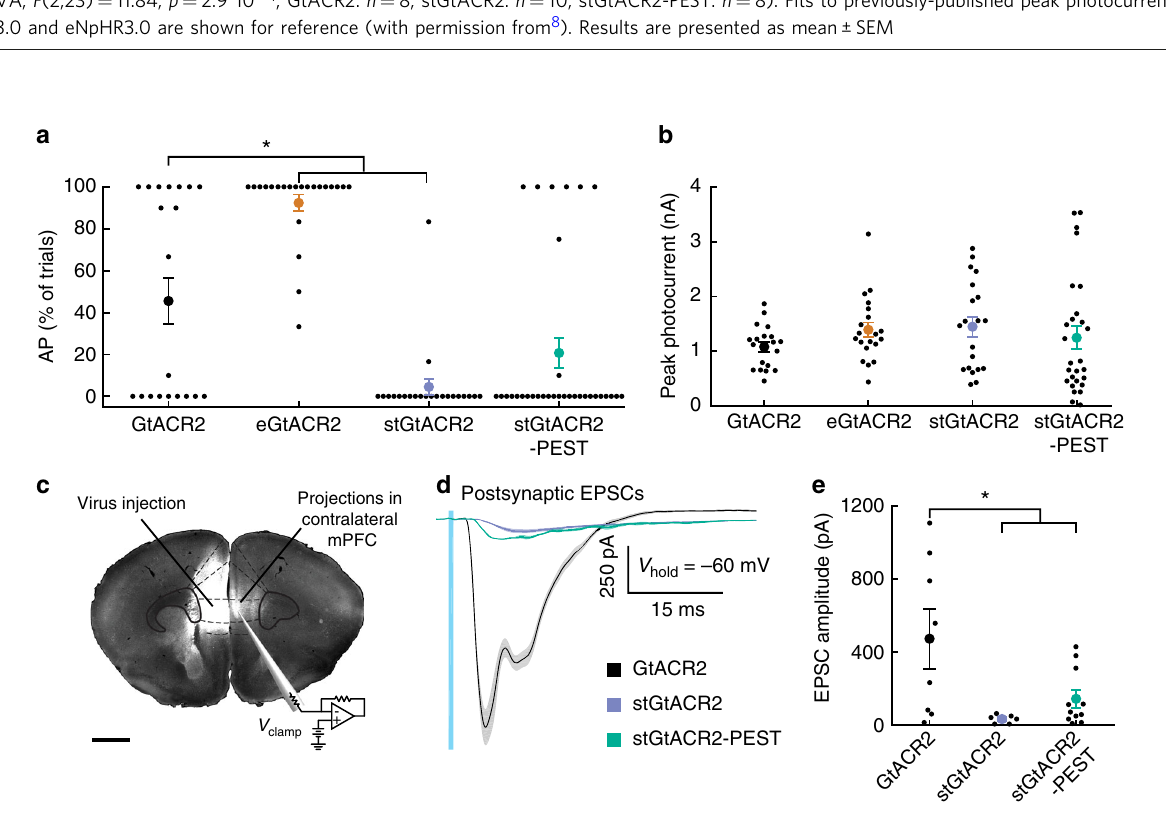
Fig. 4 Targeting GtACR2 to the somatodendritic compartment attenuates axonal excitation. a Comparison of the incidence of antidromic spikes triggered by 1 ms light pulses in virally transduced cultured hippocampal neurons. eGtACR2 has a signi fi cantly increased AP incidence, while stGtACR2 decreases the occurrence of APs (Kruskal – Wallis H -test, H (3,97) = 47, p < 10 − 4 ; GtACR2: n = 20, eGtACR2: n = 22, stGtACR2: n = 22, stGtACR2-PEST: n = 33). b Peak photocurrents did not differ signi fi cantly between the constructs, showing that reduced AP incidence in stGtACR2 transduced neurons does not stem from smaller photocurrents (ANOVA, F (3,82) = 0.83, p = 0.48). c Schematic of the experimental set-up to characterize GtACR2 triggered axonal neurotransmitter release in acute brain slices. Virus encoding a cytosolic fl uorophore was co-injected with the GtACR2 variants to allow for visualization of the axon terminals of transduced cortico-cortical projection neurons. Contralateral neurons in areas with high fl uorescence intensity were recorded. Scale bar, 1 mm. d Representative traces of excitatory post-synaptic currents in response to 1 ms light pulses (470 nm, at 4.5 mWmm − 2 ). e Quanti fi cation of the light-evoked post-synaptic current amplitude. Soma-targeting led to signi fi cant reduction in light-evoked EPSCs amplitudes (ANOVA, F (2,22) = 5.54, p = 1.13*10 − 2 ). All results are presented as mean ±